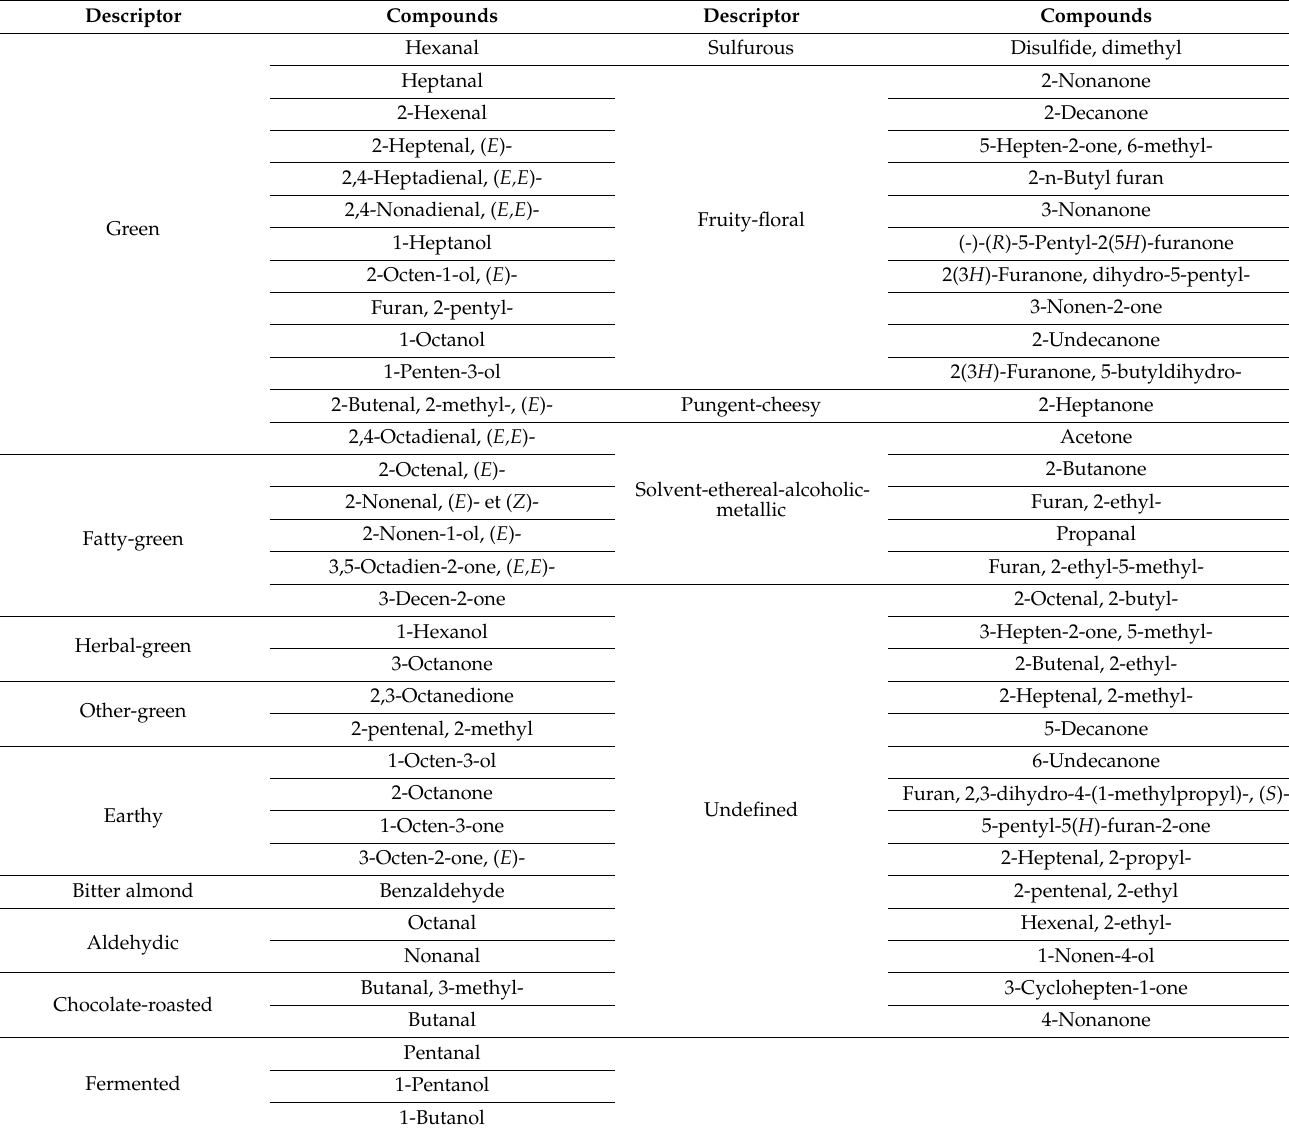
Table A3. Sorting of volatile compounds by sensory